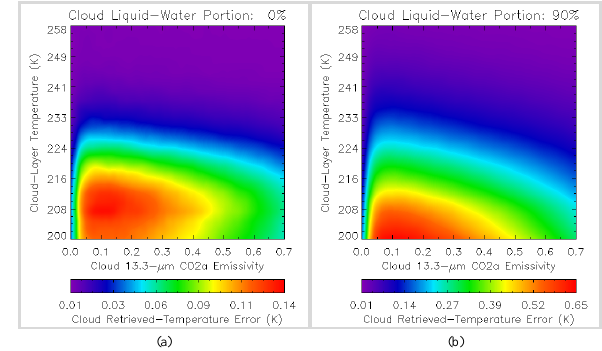
Fig. 2. Retrieved temperature error incurred by invoking the equal- emissivity assumption for (a) glaciated clouds and (b) mixed phase clouds having 90% liquid water. Clouds are described by their mid- layer temperature and their emissivity at 13.3µm, with colors show- ing the temperature error in the retrieval. See text for